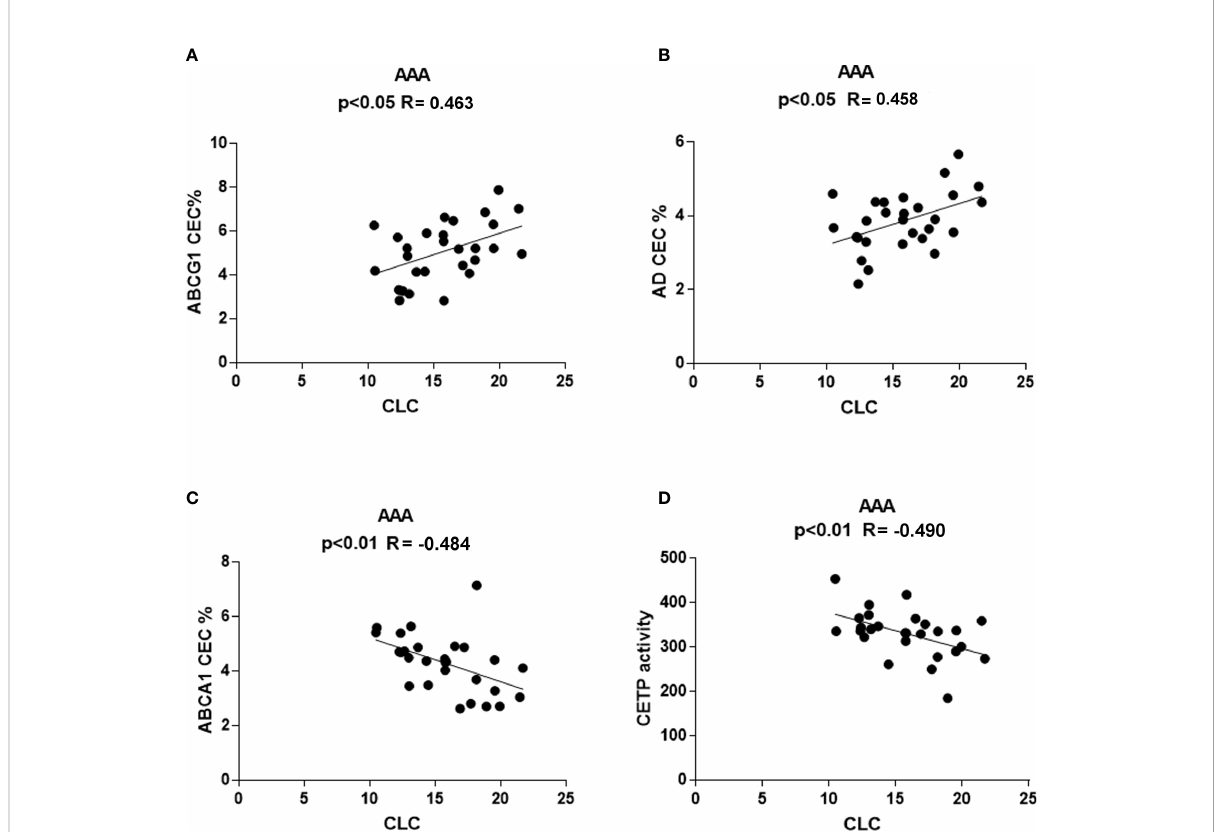
FIGURE 7 Correlations between serum CLC and other parameters in AAA patients. Positive correlation of CLC with ABCG1-CEC (A) and AD-CEC (B) and inverse correlation of CLC with ABCA1-CEC and CETP (C) activity (D) were found only in AAA